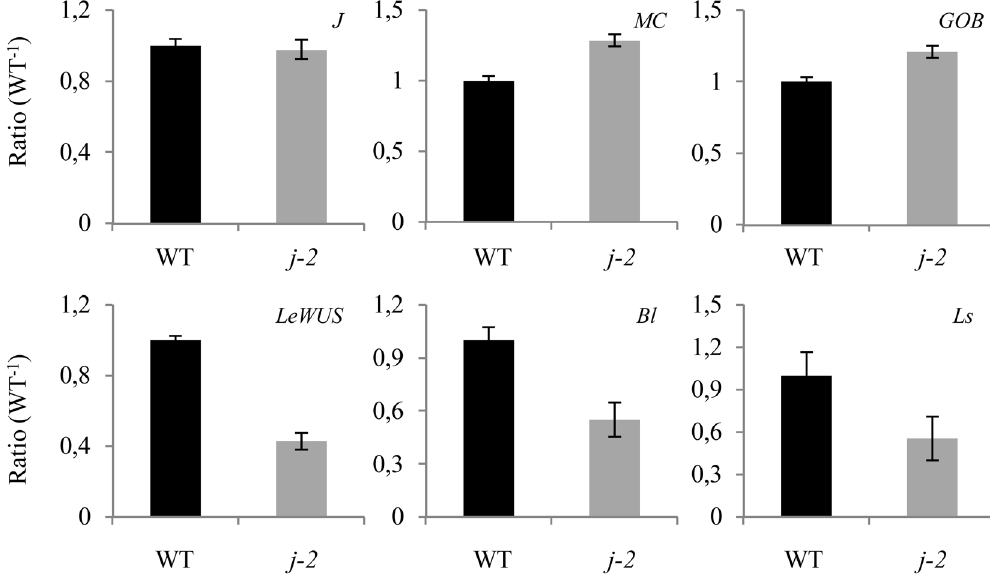
Figure 6. Expression levels of genes involved in the formation of the abscission zone of the flower pedicel in j-2 mutant (LA0315), relative to WT. J ( JOINTLESS ), MC ( MACROCALYX ), GOB ( GOBLET ), LeWUS ( WUSHEL ), Blind ( Bl ) and Ls ( LATERAL SUPPRESSOR ). Bars =